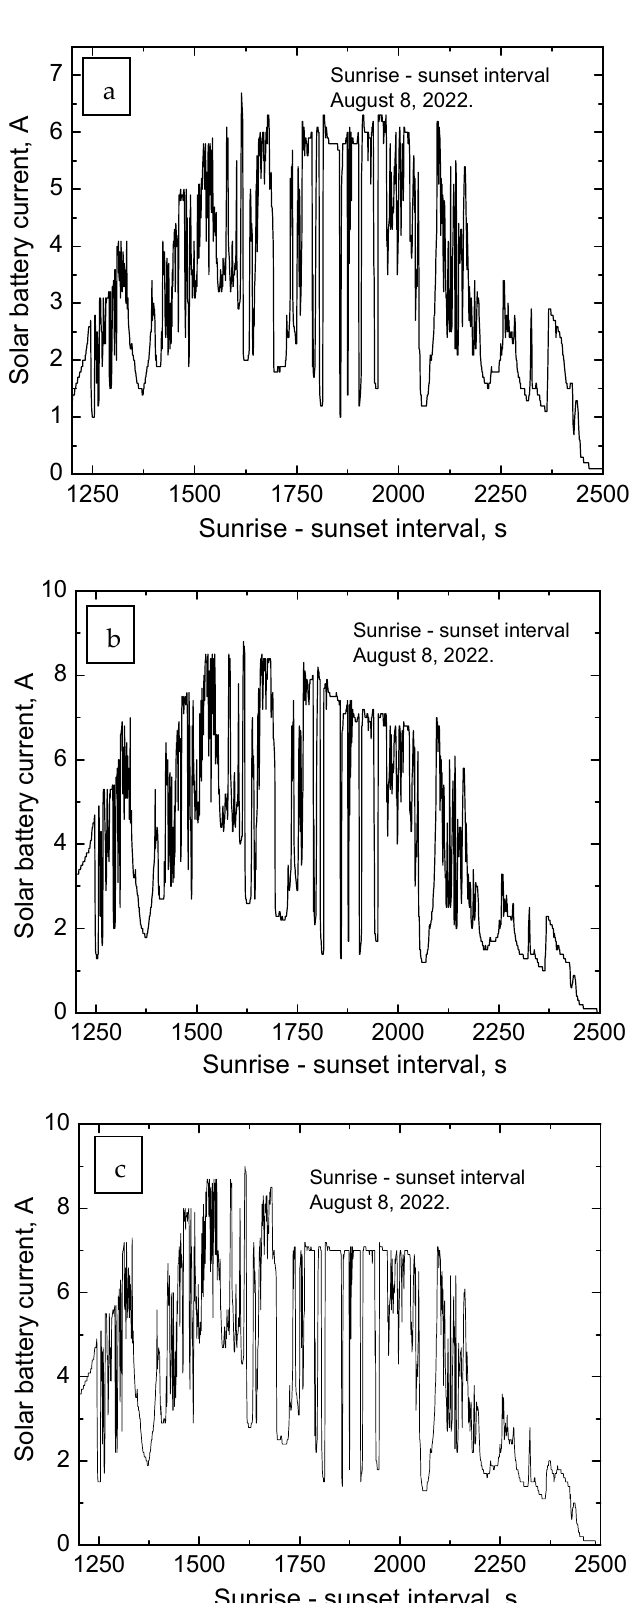
Figure 8. Dependence of solar battery (290 W) current on daylight interval: ( a ) battery used for 10 years; ( b ) new polycrystalline battery; ( c ) bifacial type battery.